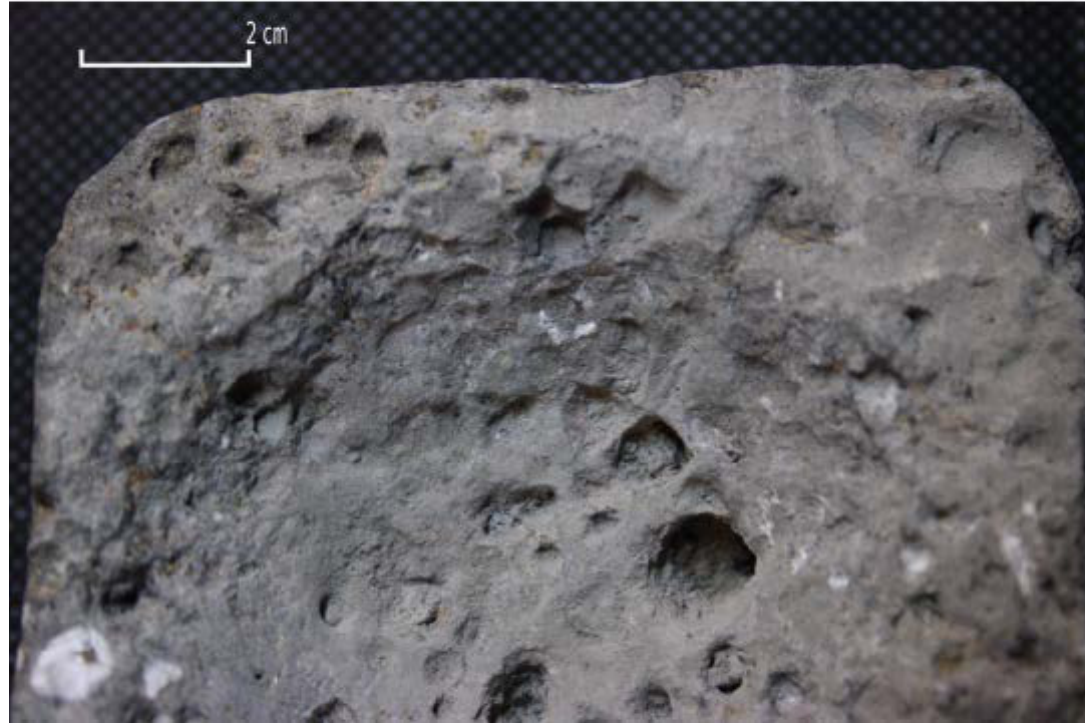
Figure 7. Close-up of the unpolished cavity